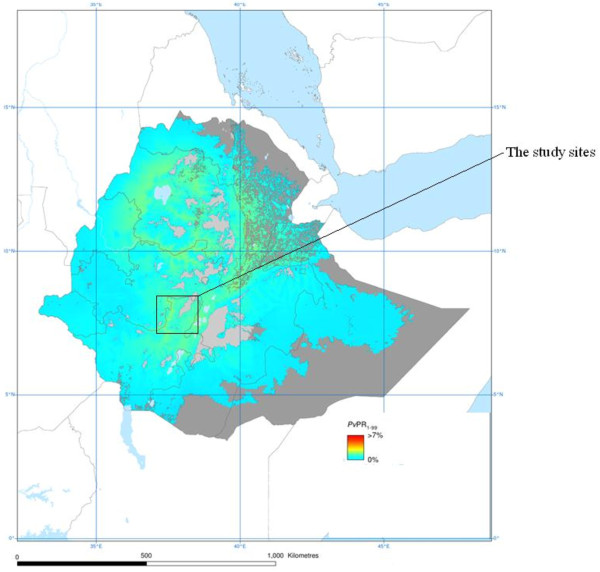
Map of the study sites.